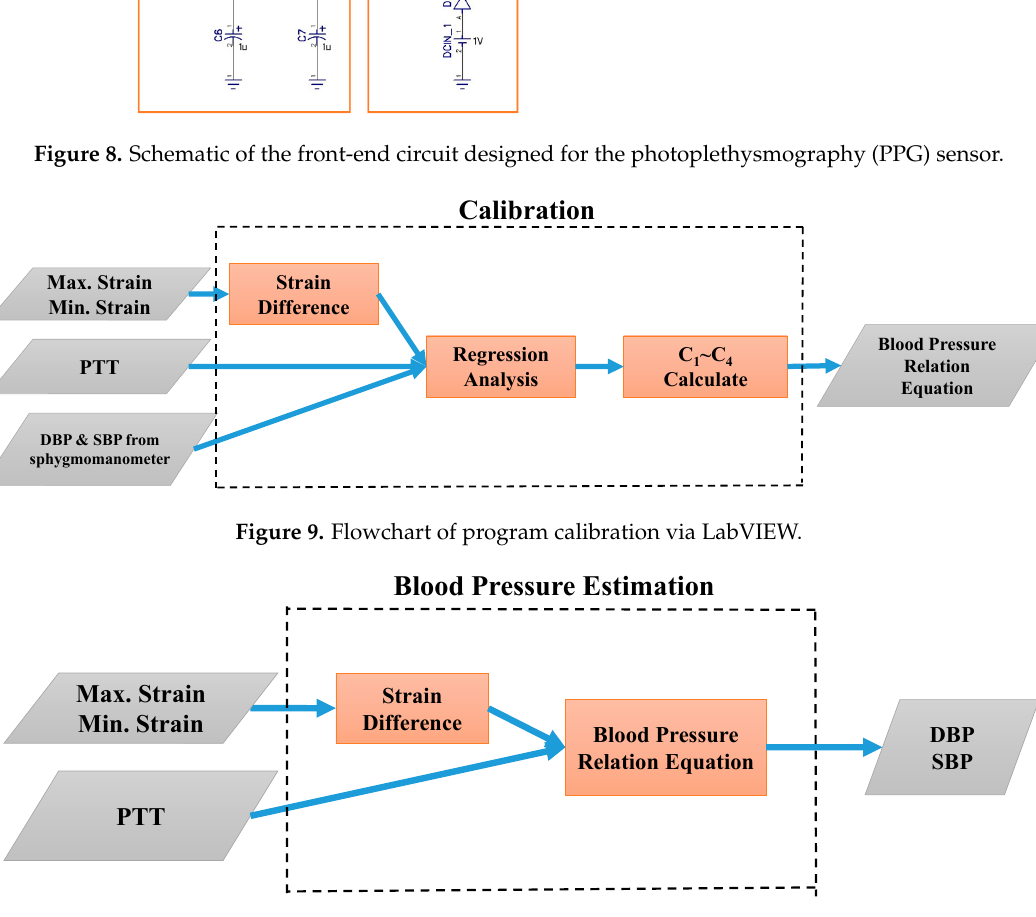
Figure 10. Flowchart of BP estimation via LabVIEW.